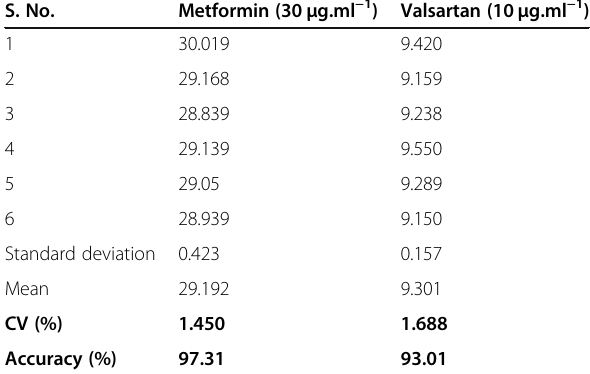
Table 1 System suitability: metformin-valsartan S.